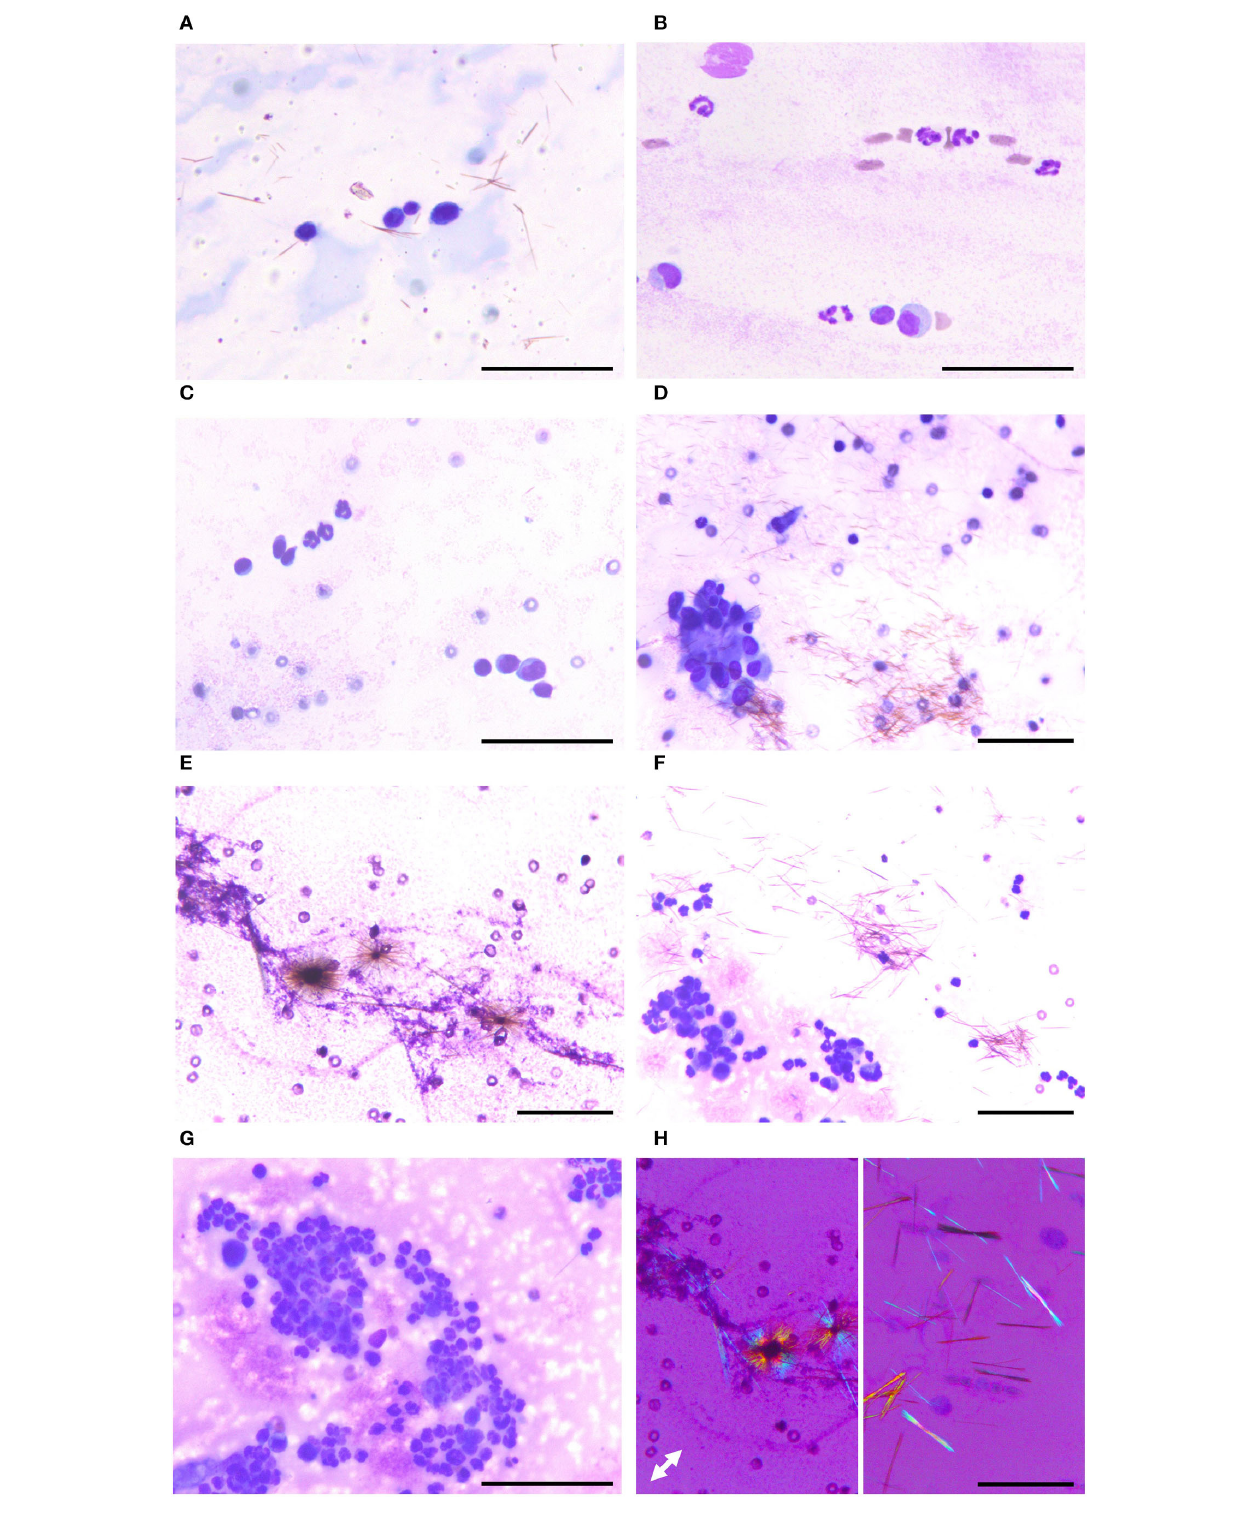
FIGURE 2 | Various appearances of articular gout on synovial fluid smear cytology. (A) Case 1. Smear slide of the right stifle joint synovial fluid. Three large mononuclear cells and one small mononuclear cell are seen with numerous monosodium urate crystals. (B) Case 2. Smear slide of the right stifle joint synovial fluid. Two large mononuclear cells, one small mononuclear cell, and several neutrophils are seen. (C,D) Case 3. Smear slide of left tarsal joint synovial fluid. Both small and